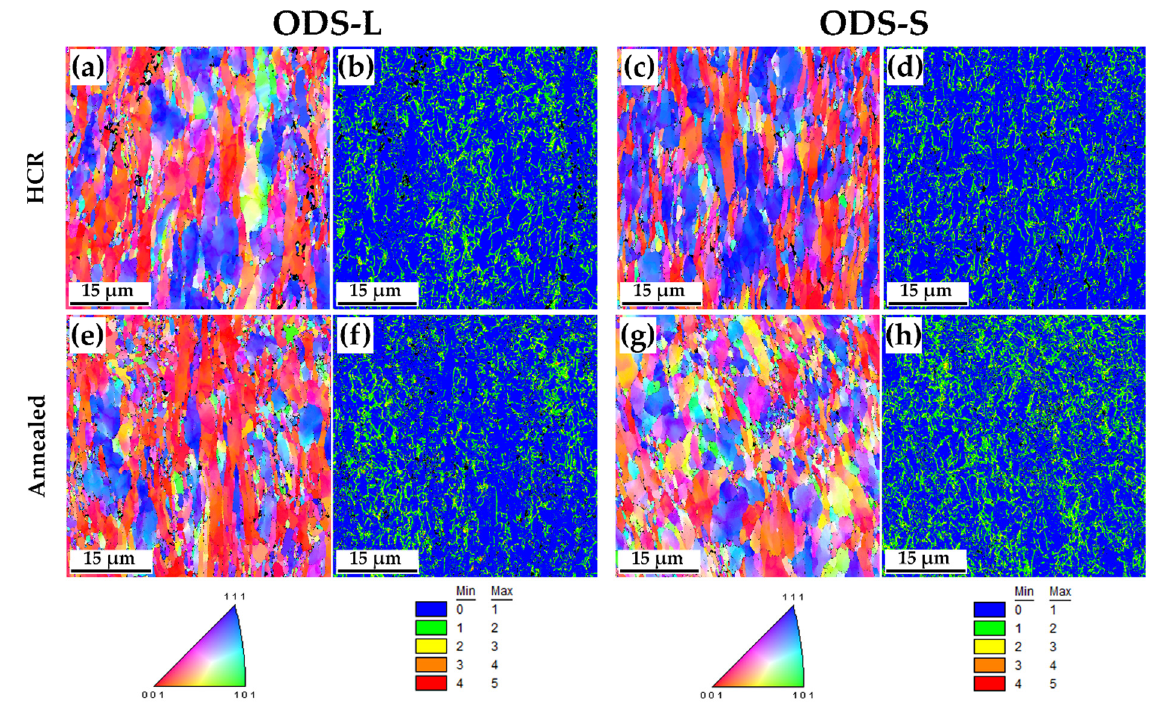
Figure 8. IPF and KAM maps taken on the TS plane for the ODS steels after HCR and after annealing at 1273 K. IPF maps: ( a ) ODS-L after HCR, ( c ) ODS-S after HCR, ( e ) ODS-L after annealing, and ( g ) ODS-S after annealing. The respective KAM maps are depicted on ( b , d , f , h ).